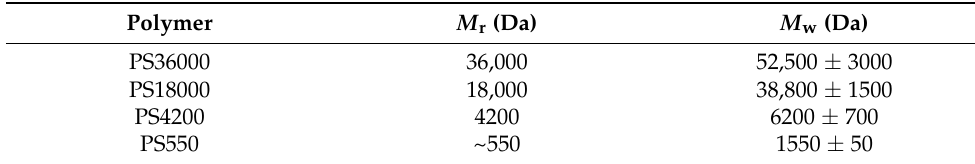
Table 1. Molar mass values for PDMS-OH siloxanes in isopropanol M w : weight-average molar mass values in isopropanol from sedimentation equilibrium in the analytical ultracentrifuge. M r : relative molar mass values relative to polystyrene standards.